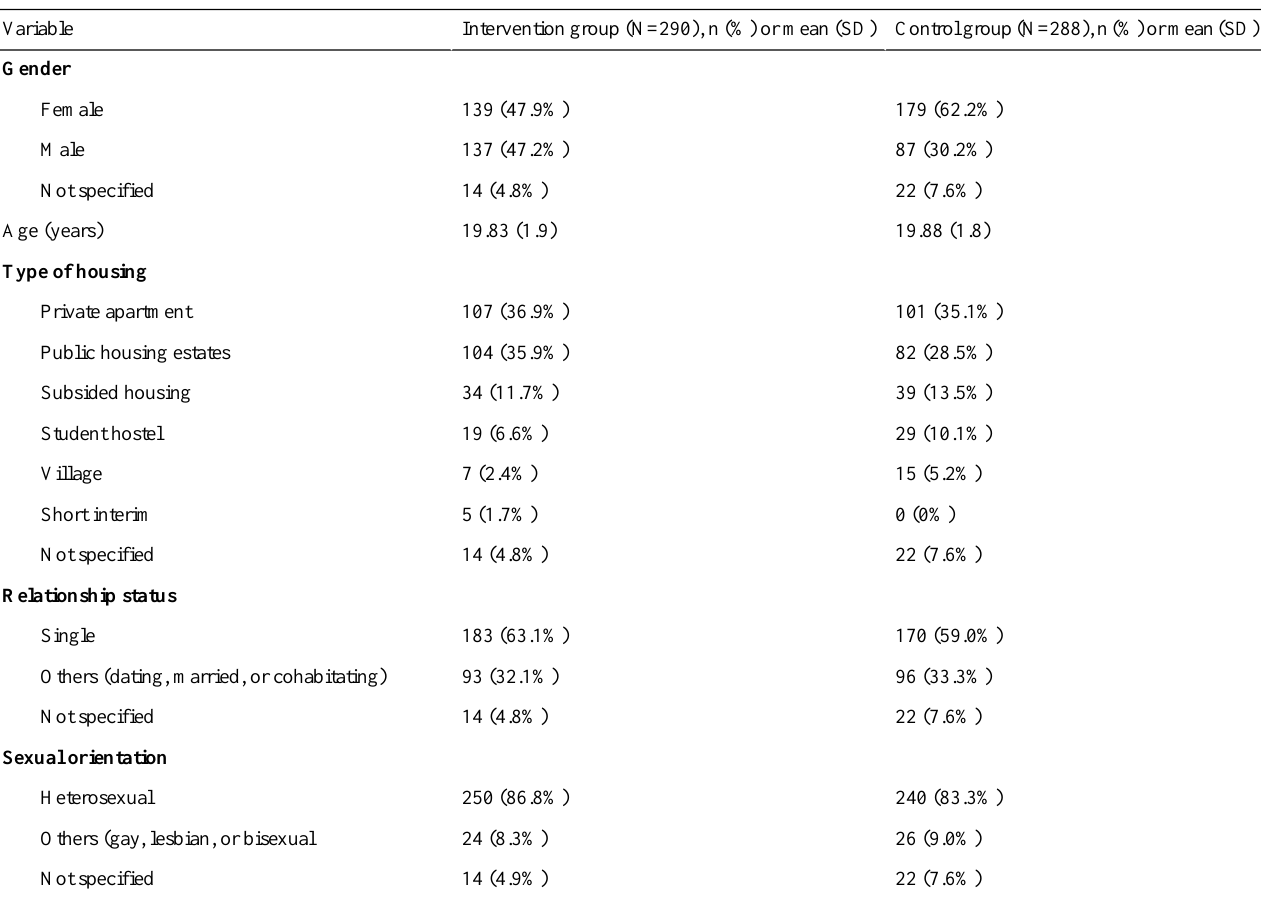
Table 1. Baseline sociodemographic characteristics of the participating college